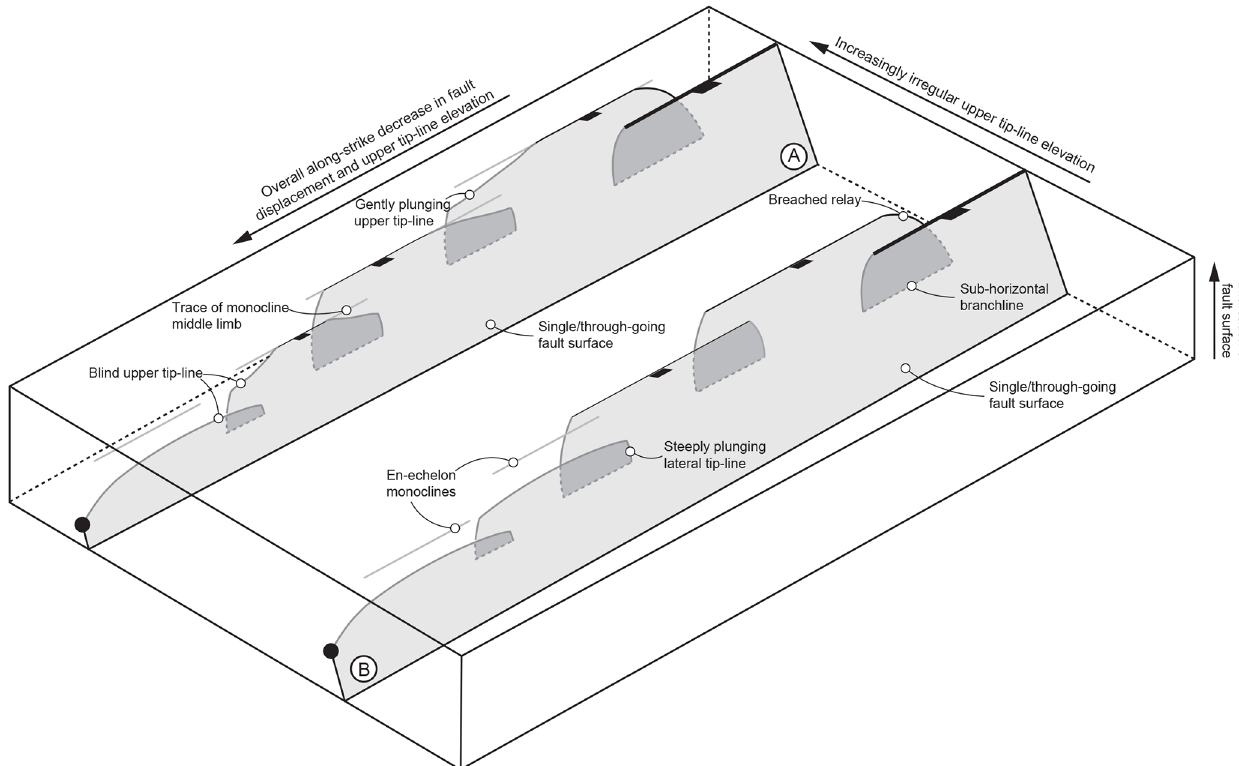
Figure 20. Schematic diagram summarizing some of the key observations from the Hadahid Fault System and outlining key structural elements of segmented normal fault–fault propagation fold systems. Fault A is defined by an irregular upper tip-line elevation, superimposed on a net right-to-left decrease in elevation and net fault displacement (i.e. the Hadahid Fault System); Fault B is defined by an more smoothly decreasingly fault displacement and elevation of the upper tip line. Footwall-anticline–hangingwall-syncline pairs, which represent breached fault-propagation folds (monoclines) and that flank the breaching faults, are not shown for